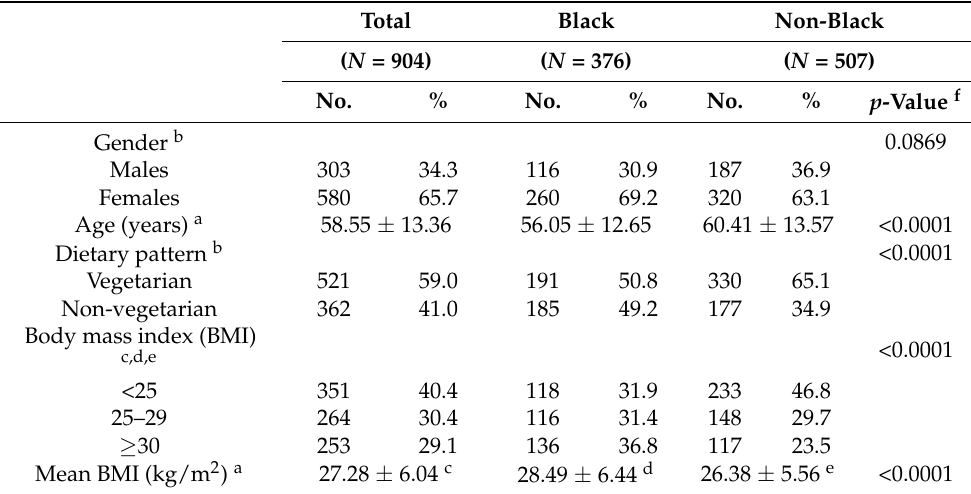
Mean BMI (kg/m 2 ) a